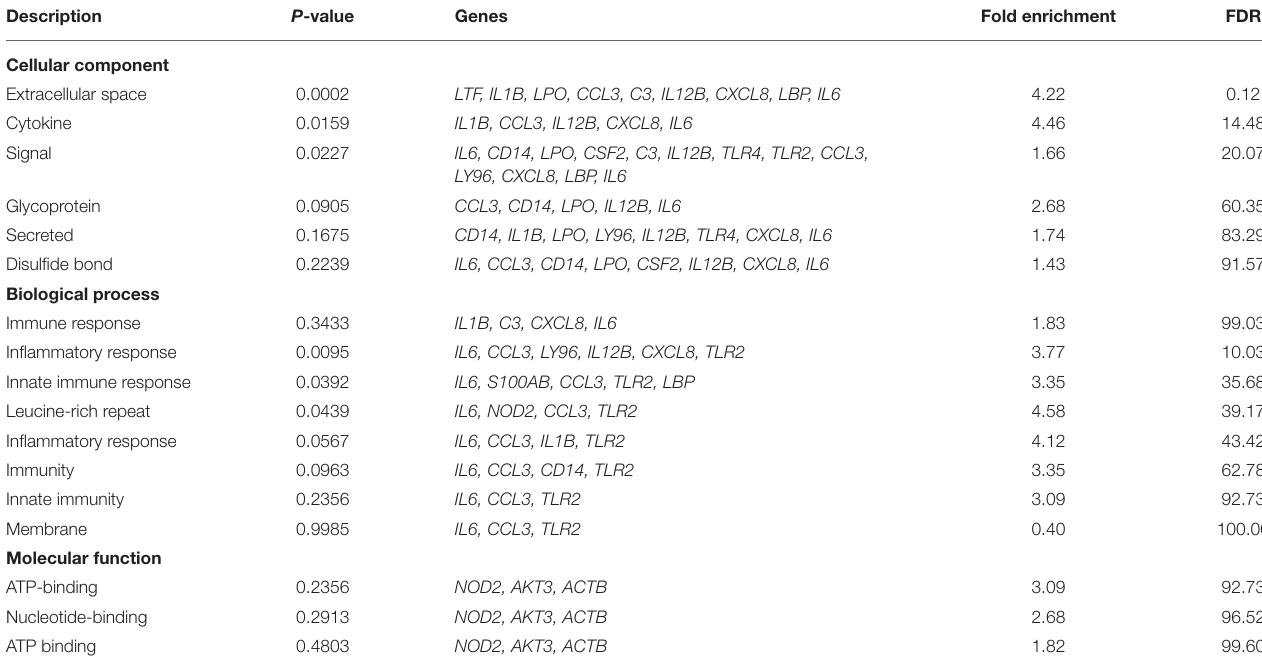
TABLE 1 | Gene ontology analysis of candidate genes through DAVID.